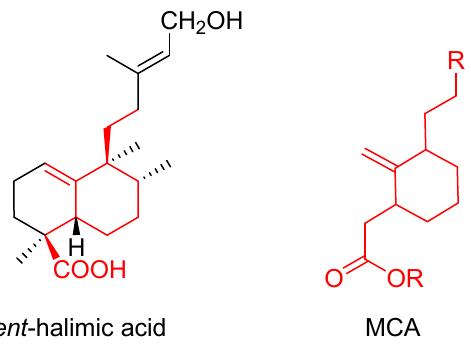
Figure 1. The methylene-cycloalkylacetate (MCA) scaffold for novel neurotrophic agents and ent -halimic acid, the halimane reference compound.